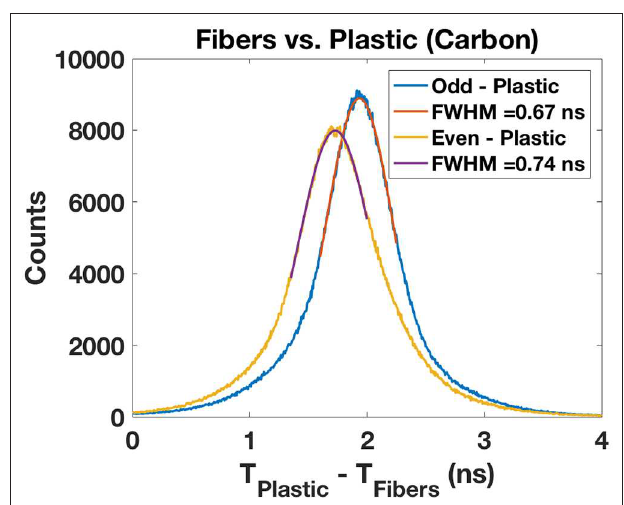
FIGURE 9 | Intrinsic time resolution for the odd and even scintillating fibers present within the alternating fashion. A reproducible value of 0.7 ns is obtained for both fiber